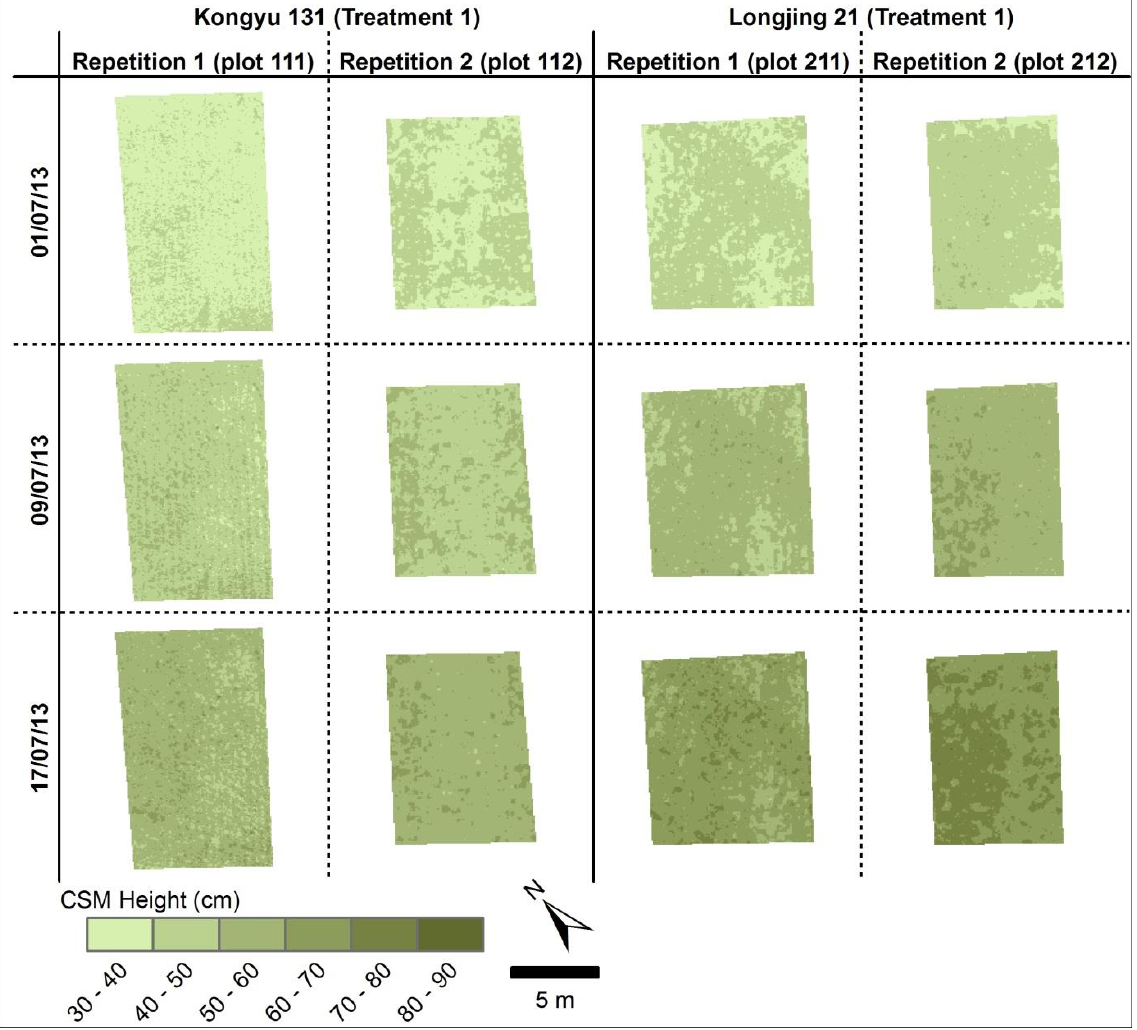
Figure 2. Crop surface models (CSM) visualised as maps of height for four selected plots on each campaign date (Plots are marked in Figure